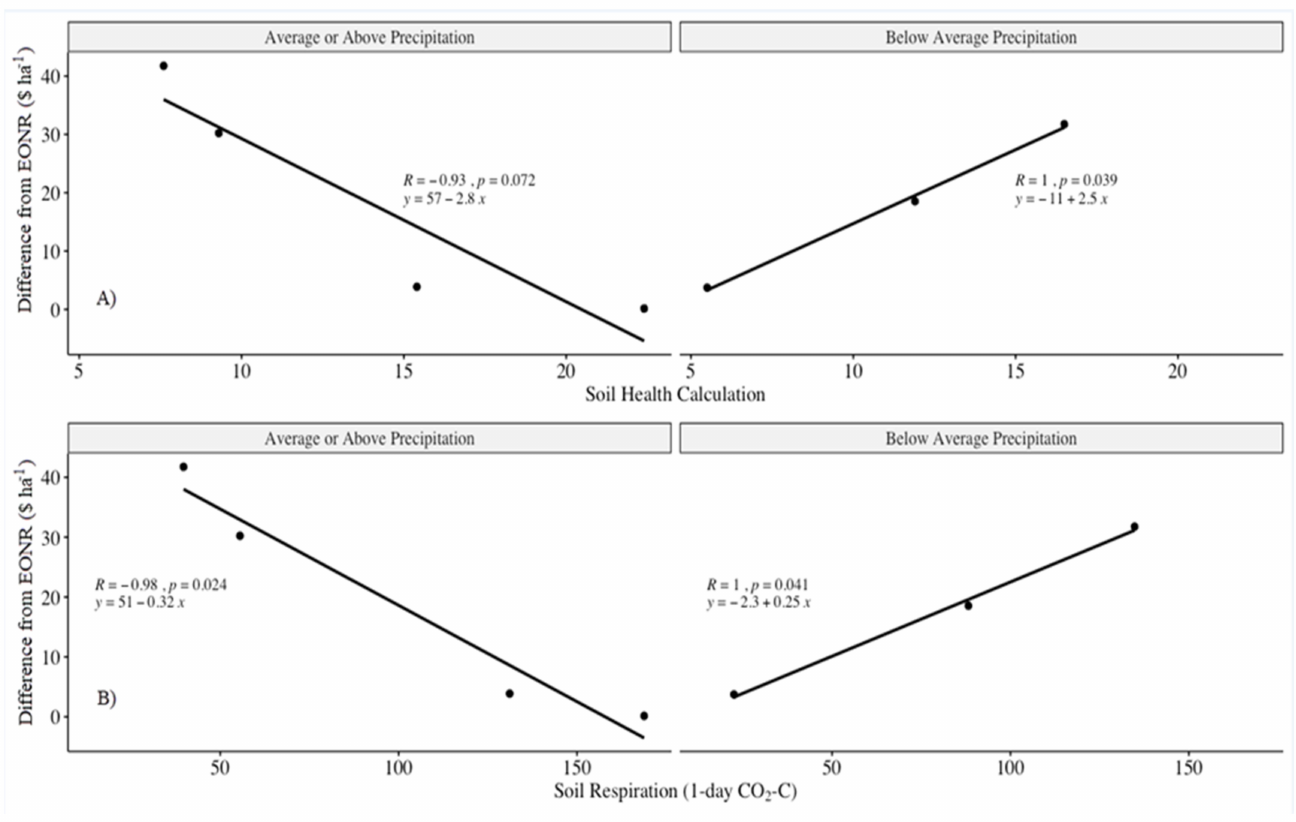
Figure 4. Regression of the difference in return from the HSTN and EONR (EONR − HSTN) on soil